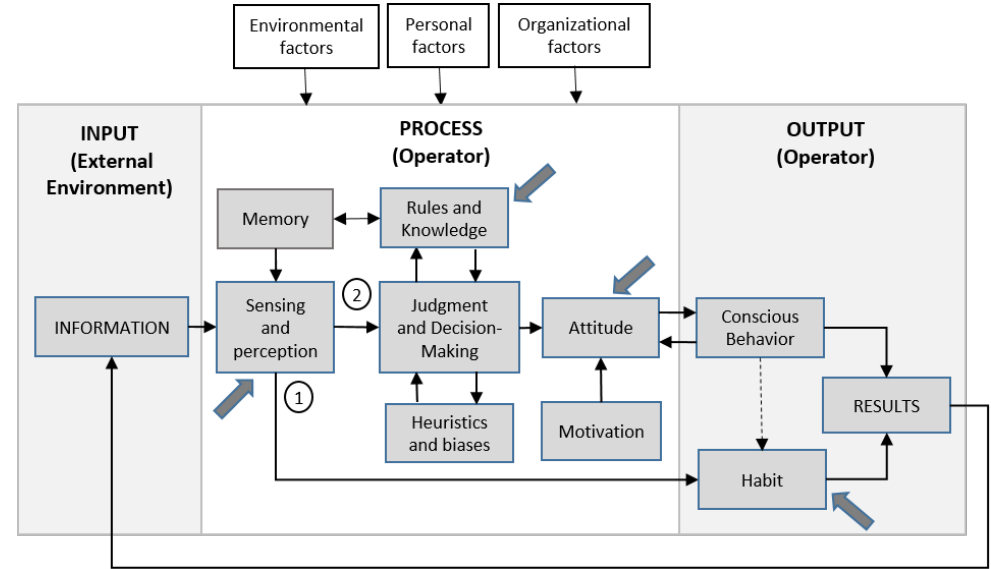
Figure 2. Cognitive map of operator behavior based on [60].